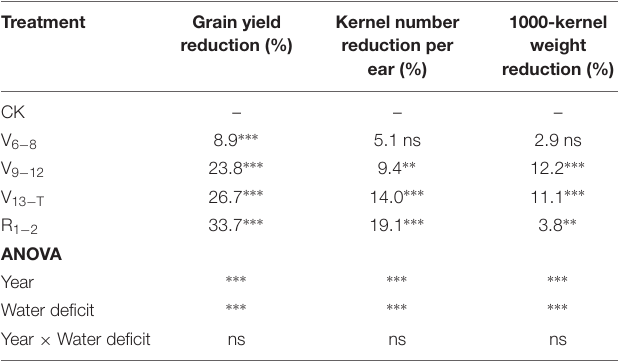
TABLE 1 | Average reduction of maize grain yield (%), kernel number per ear (%), and kernel weight (%) that resulted from water deficits during 2014–2016.